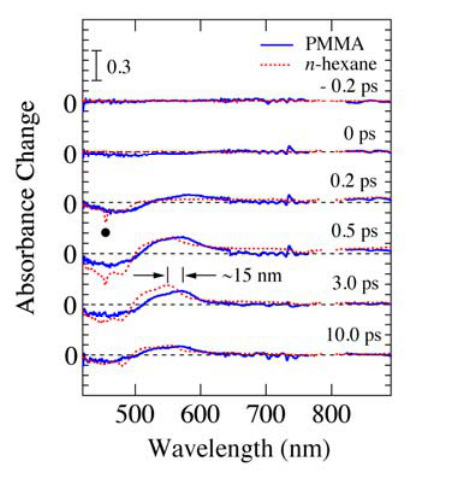
Figure 13. Time-resolved absorbance change spectra of β -carotene in PMMA films with different delay times. As comparison, the spectra of β -carotene in n -hexane solution measured by the conventional pump-probe transient absorption spectroscopy are also shown by dotted